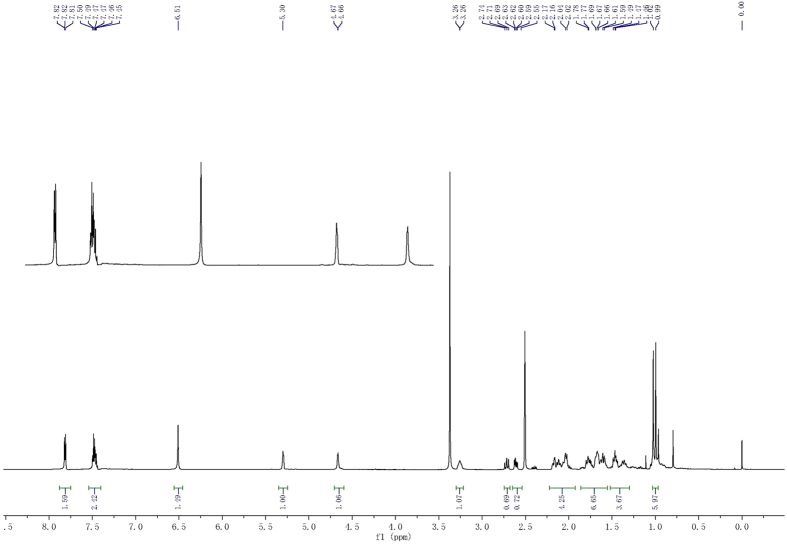
Representative 1H NMR spectra for compound 3a.